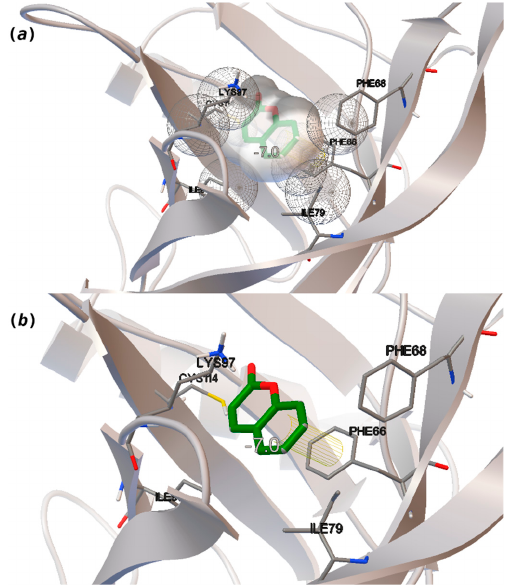
Figure 3. Interaction binding modes of coumarin (10) in hOBP, estimated with AutoDock Vina. In ( a ), van der Waals/hydrophobic interactions are represented, and in ( b ), a pi-pi interaction between coumarin ring and Phe residue. Coumarin is shown in green sticks and amino acids participating in the binding, from hOBP, in gray lines.